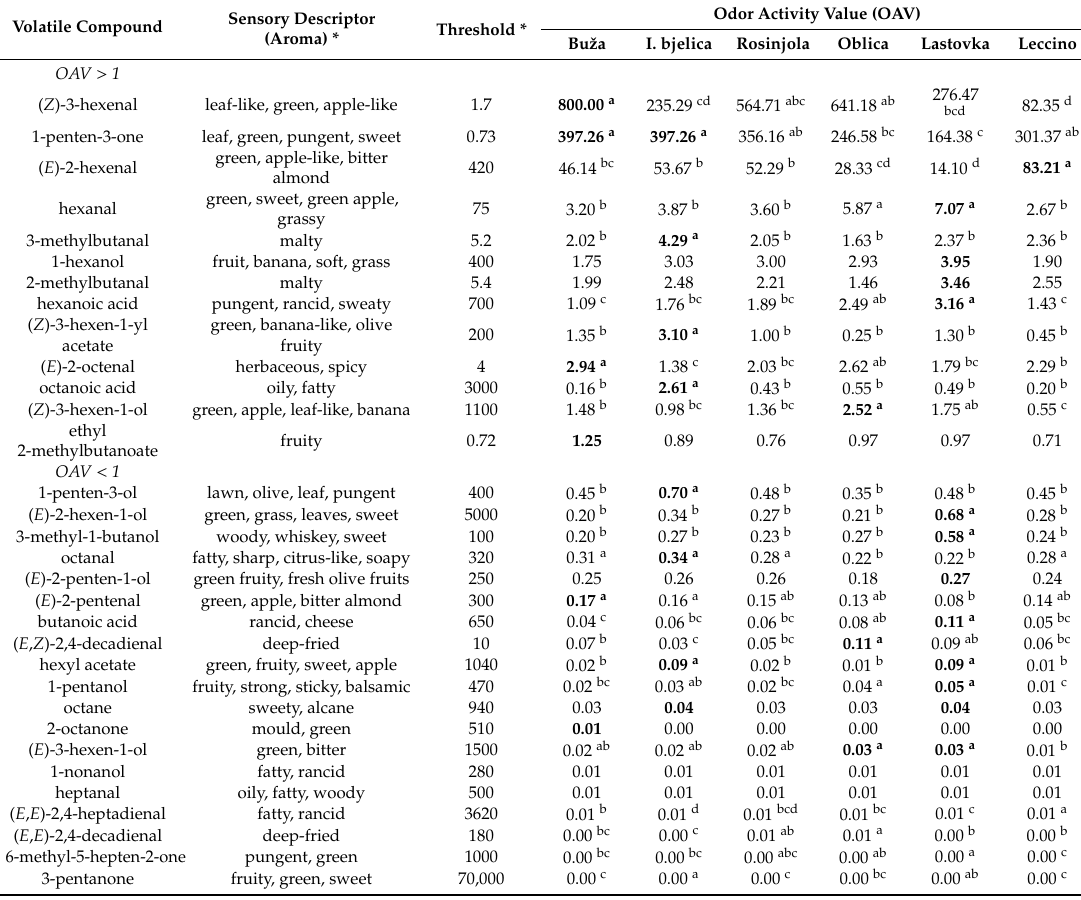
Table 2. Sensory descriptors and odor perception thresholds of volatile aroma compounds in monovarietal extra virgin olive oils produced from Buža, Istarska bjelica, Rosinjola, Oblica, Lastovka, and Leccino varieties in Croatia, sorted in descending order according to their average odor activity values